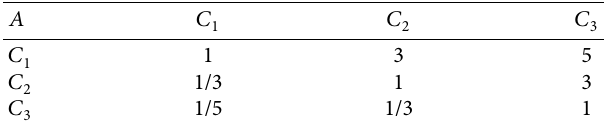
Table 3: Te judgment